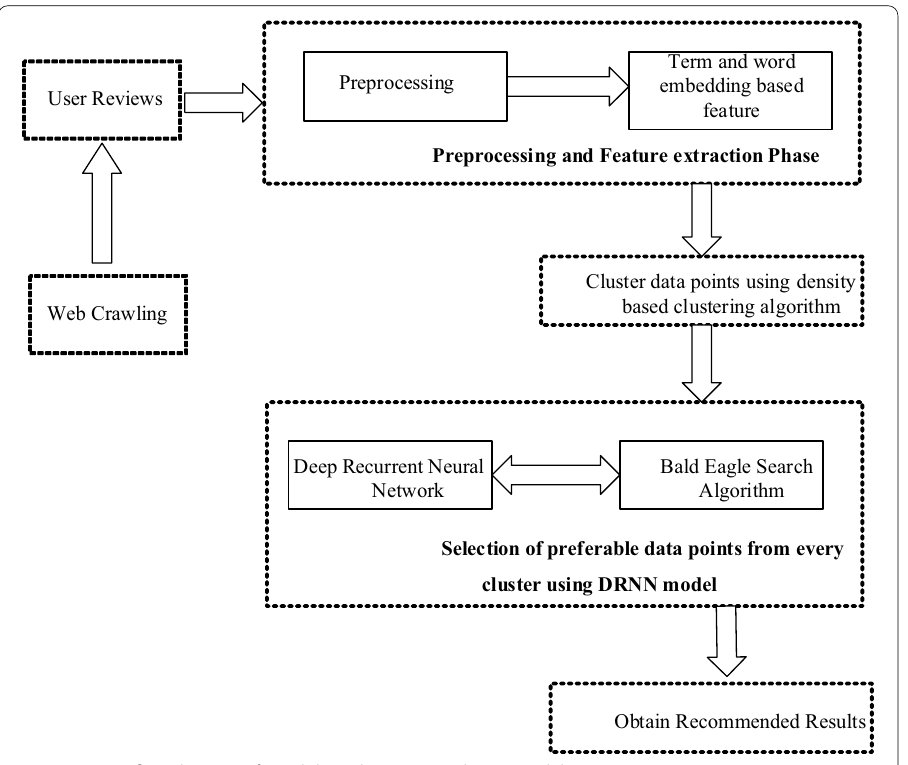
Fig. 1 Process flow diagram of graph based recommendation